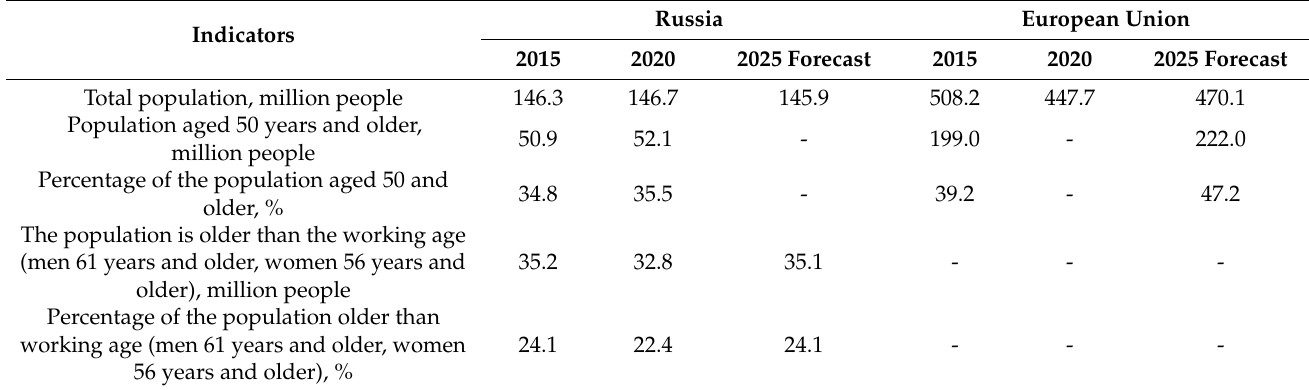
Table 1. Dynamics of the elderly population in Russia and the European Union.